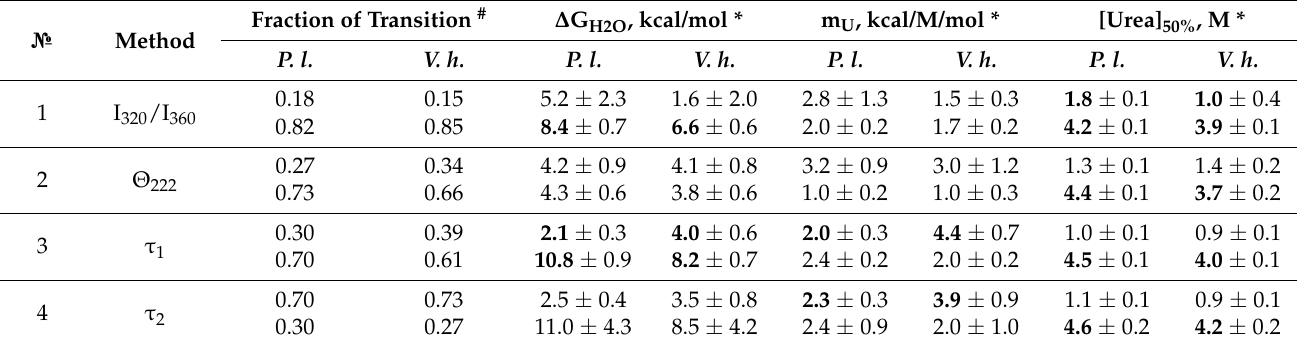
Table 1. Thermodynamic parameters of two stages of luciferase unfolding with urea. The parameters which differ for the two luciferases are in bold.